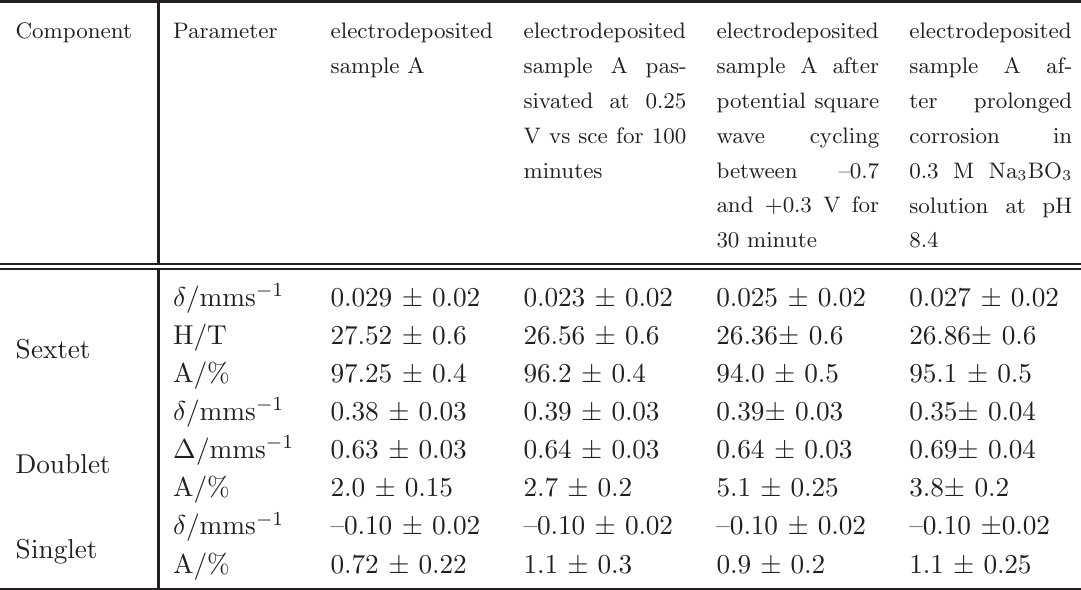
Table 2 M¨ossbauer parameters of electrodeposited and thermally prepared Fe-Ni-Cr samples.